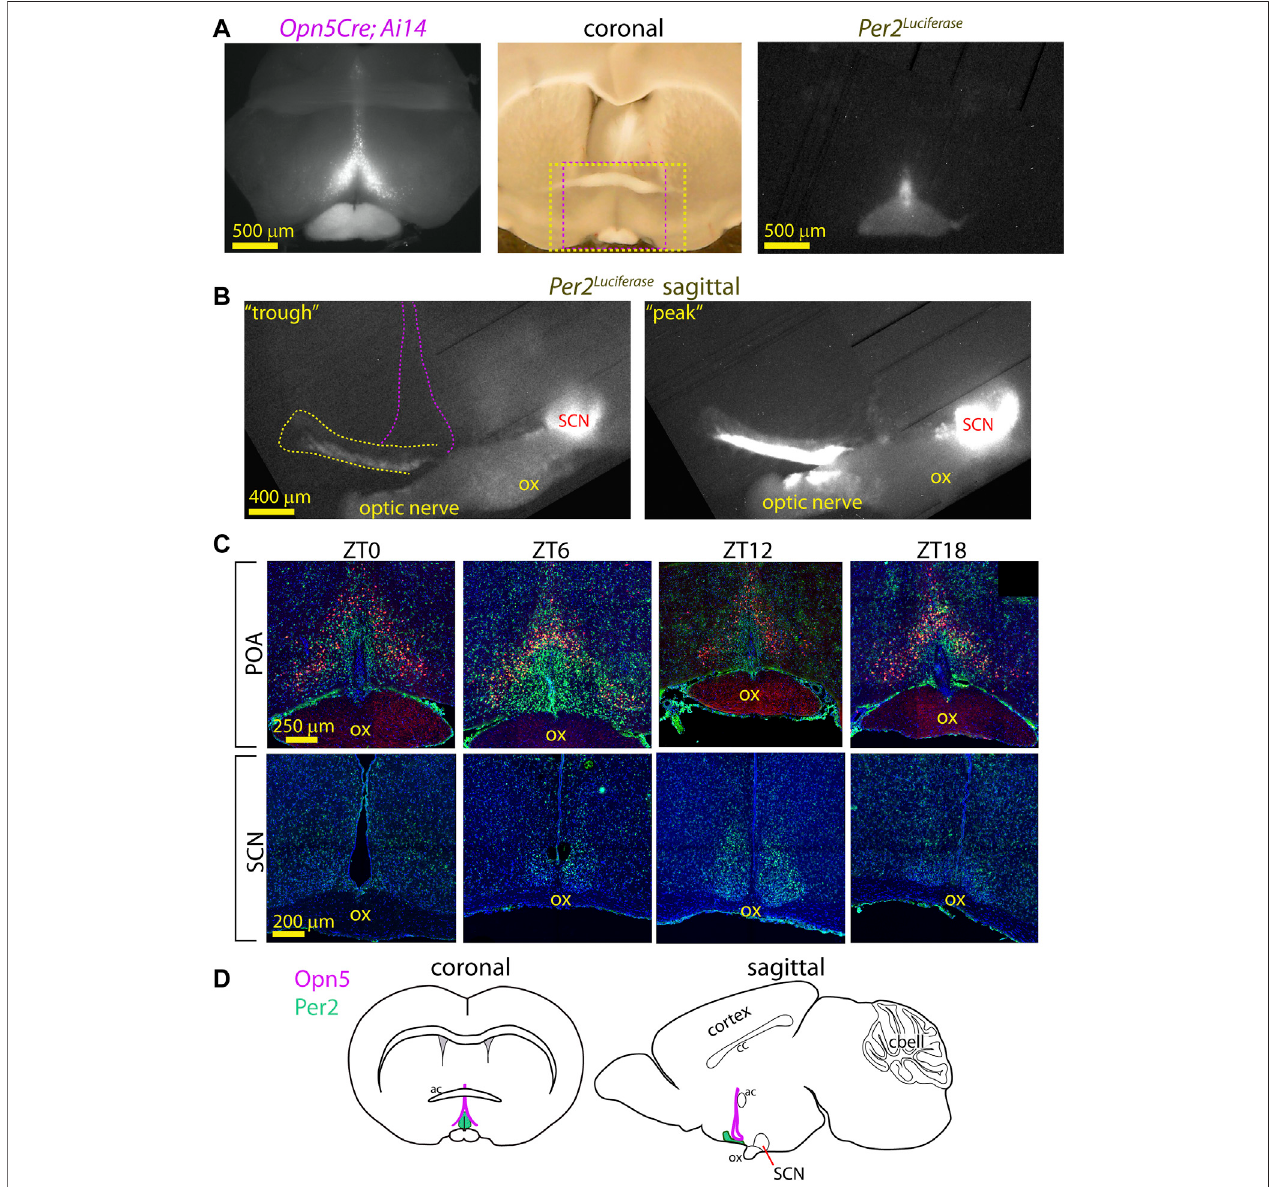
FIGURE2| AnatomyofPER2regionnearOpn5expressioninVMPO. (A) FluorescenceimageoftdTomatoexpressionincoronalsectionof Opn5 Cre/+ ;Ai14 mouse (left). Long-exposure (3 h) photo of Per2 Luciferase bioluminescence from the same section (right). Center: Full light photo of coronal brain section with red dashed box indicating region of fl uorescence (left) image and yellow dashed box indicating region of luciferase (right) image. (B) Bioluminescence of Per2 Luciferase from a sagittal hypothalamusshowingPOAregion(yellowdash)inreferencetotheSCNandthegeneralareaofOpn5expression(violetdashedlines).3 hexposuresfromaphase roughly centered on previous CT0 (left, “ trough ” ) or CT12 (right, “ peak ” ). “ ox ” = optic chiasm. (C) Fluorescence images oftdTomato (red), PER2 (green) and nuclei(blue) inPOA(upper)andSCN(lower)incoronalslicesof Opn5 Cre/+ ;Ai14 miceattheindicated zeitgeber times. N =3ateach timepoint. (D) Schematicdiagramsofthemouse brain with regions of Opn5 and POA-PER2 expression